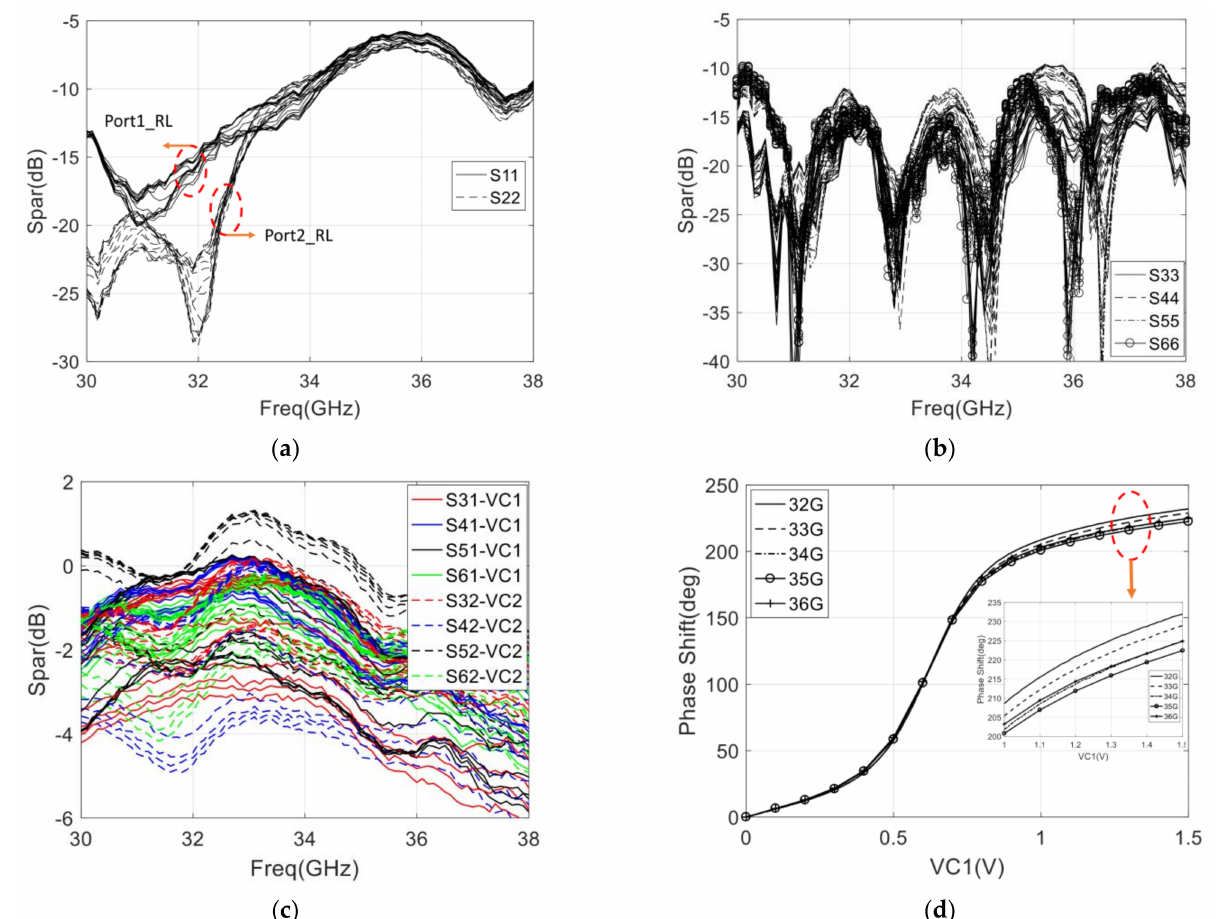
Figure 19. Simulation result of the integrated six-port chip with control voltage varying from 0 to 1 V: ( a ) Return loss of each port; ( b ) The gain of four output ports; ( c ) Phase shift range with control voltage (VC1) variances; ( d ) Phase shift range with control voltage (VC2)